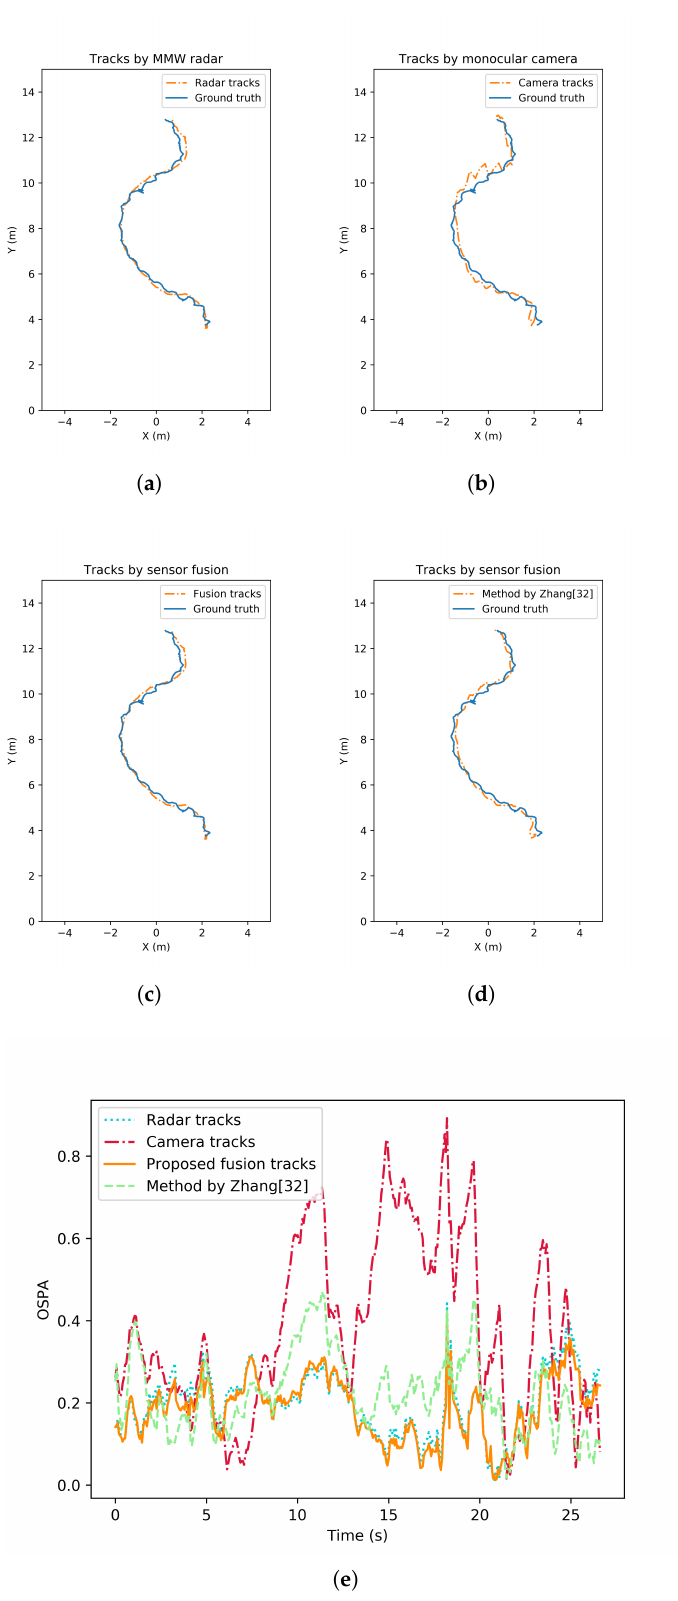
Figure 7. Pedestrian tracking performance comparison under single target situation. ( a ) Tracking trajectories by MMW radar. ( b ) Tracking trajectories by monocular camera. ( c ) Tracking trajectories by the proposed fusion strategy. ( d ) Tracking trajectories by the method from [32]. ( e ) Tracking performance comparison in